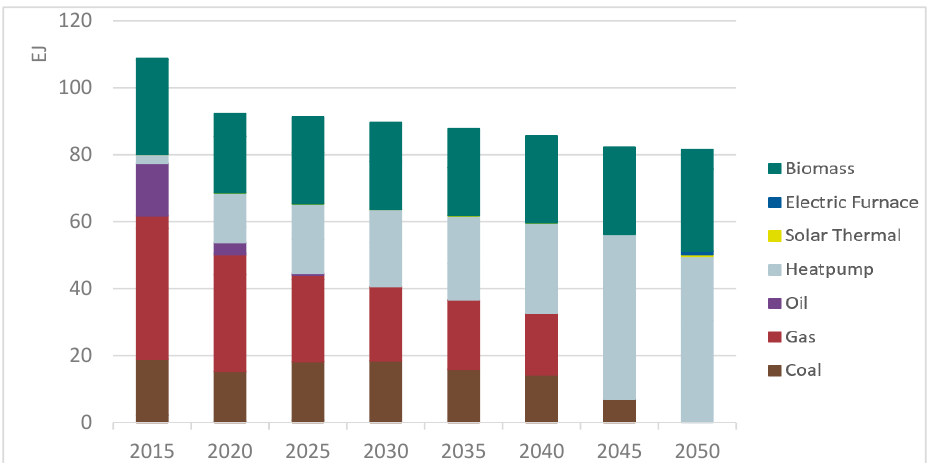
Figure 7. Development of global high-temperature heat production.